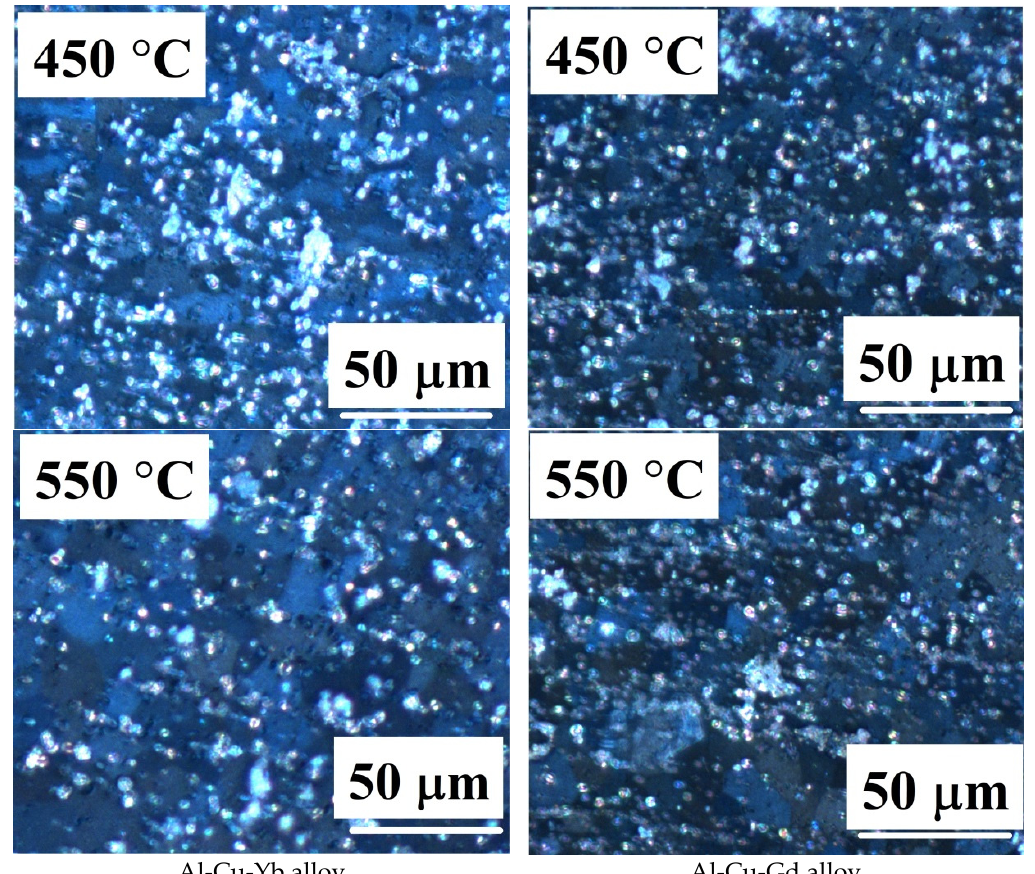
Figure 8. Grain structure of the investigated alloys in the annealed at 250–550 °C for 1 h after rolling conditions.